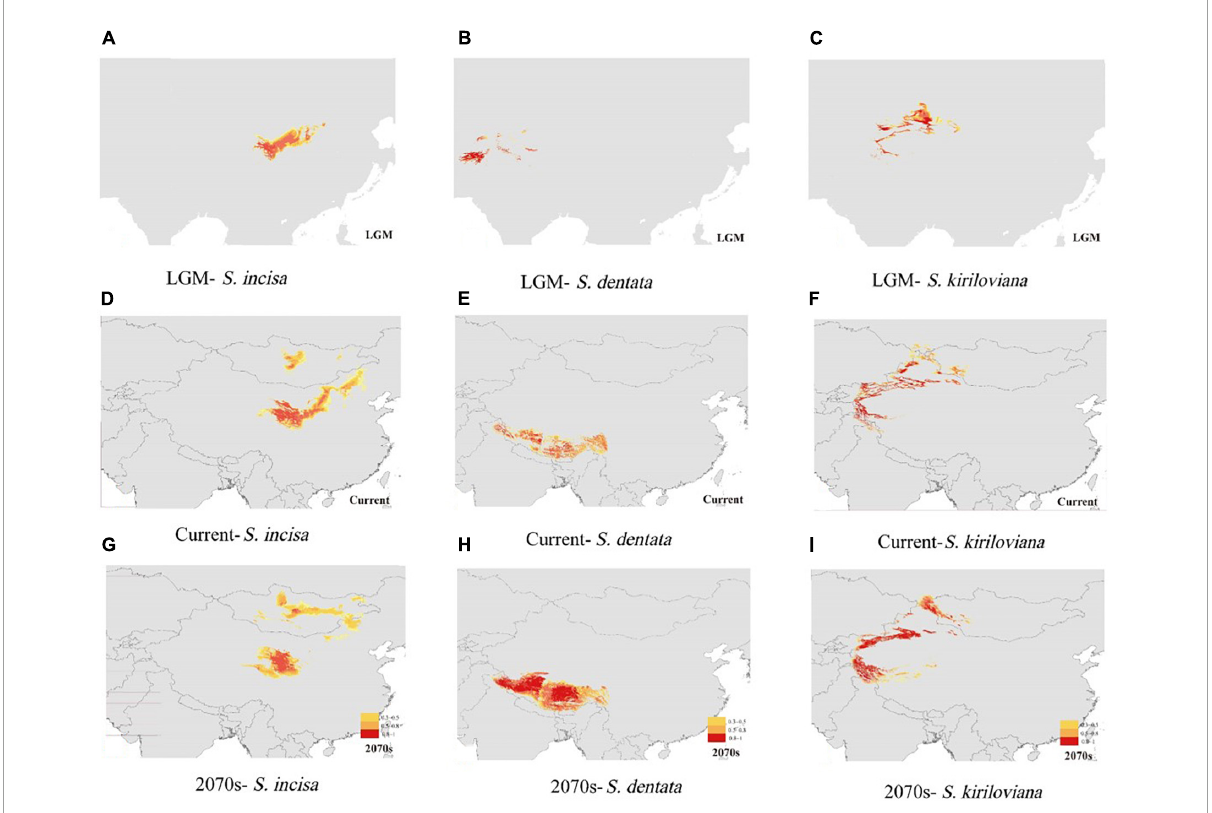
FIGURE5 Predicted distributions of S. incisa, S. dentata, and S. kiriloviana at the (A–C) Last Glacial Maximum (LGM; 21 000 year before present; BP), under (D–F) current conditions (1950–2000), and (G–I) future (2070s) based on ecological niche modeling using MAXENT v3.3.1 (Phillips et al., 2006). Maps were generated using ARCGIS v9.3 (ESRI, Redlands, CA,